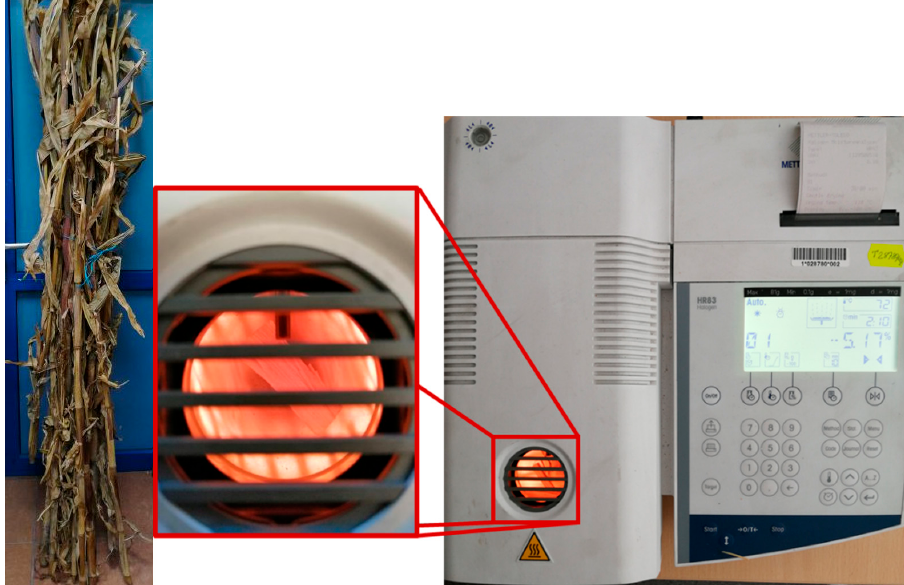
Figure 1. General view of the seasoned corn stalks ( left ), determining the moisture content of the corn stalks using a scale-dryer ( right ).